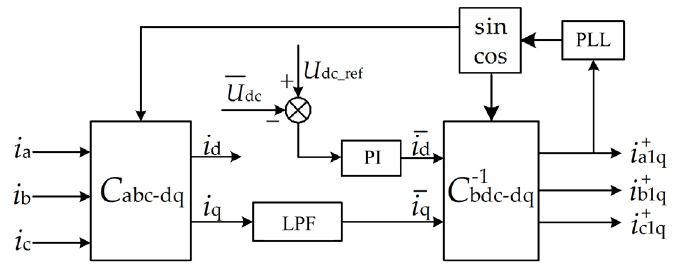
Figure 4. Block diagram of reactive current detection for SVG.